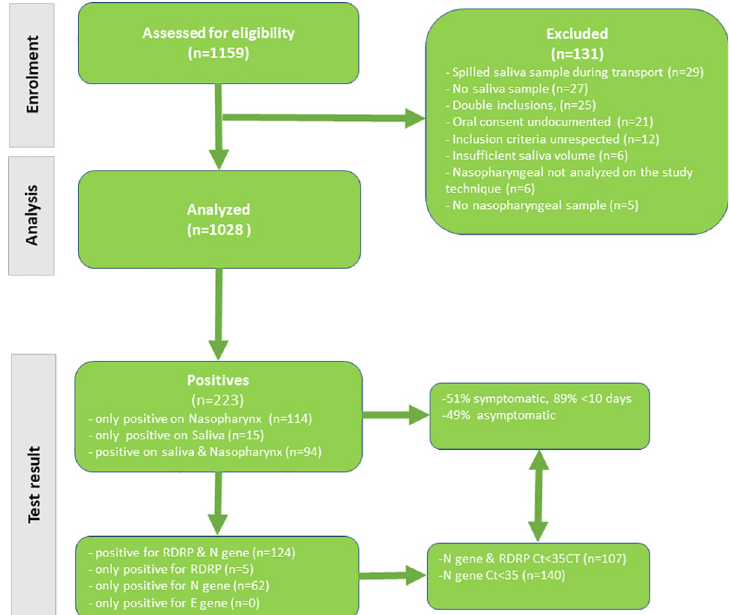
Fig 1. COVISAL study flowchart. The top half of the flowchart shows the cascade of the number of patients screened and the number of patients that were included in the analysis and the reasons why some were excluded. The bottom half of the flowchart shows the number of ‘positives’ (according to the manufacturer) by type of sample and the proportion of symptomatic patients and among these those that had symptoms less than 10 days before inclusion. Finally, the bottom left of the flowchart breaks down positives by target gene and the bottom right shows the number of positives with Ct < 35, which are assumed to be most infectious and most important to